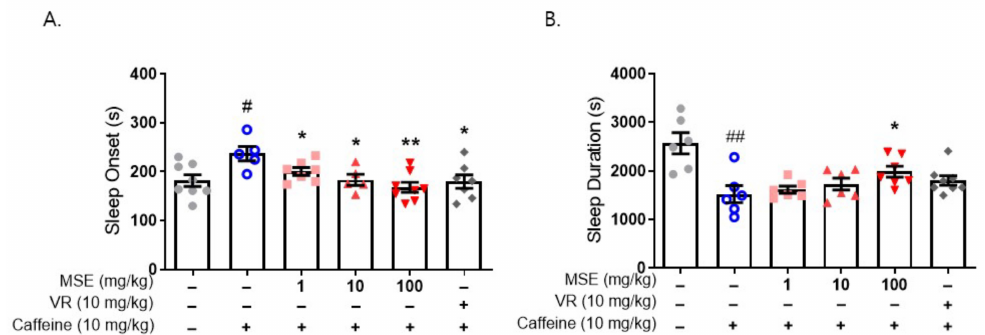
Figure 4. Effects of Maydis stigma extracts on caffeine-induced sleep disturbance. Mice were adminis- tered MSE (1, 10, 100 mg/kg) and positive control (valerian root extract; VR, 10 mg/kg) for 7 days orally. Sleeping test was performed on day 8. Sleep deprivation was with caffeine (10 mg/kg, i.p.) in- jection, and then pentobarbital sodium (42 mg/kg, i.p.) injected for sleep induction. Sleep latency and sleep duration were measured as described in Section 4. ( A ) Sleep latency (s), ( B ) sleep duration (s). # p < 0.05, ## p < 0.01; Veh vs. Caffeine. * p < 0.05, ** p < 0.01; Caffeine vs. MSE and VR (N =